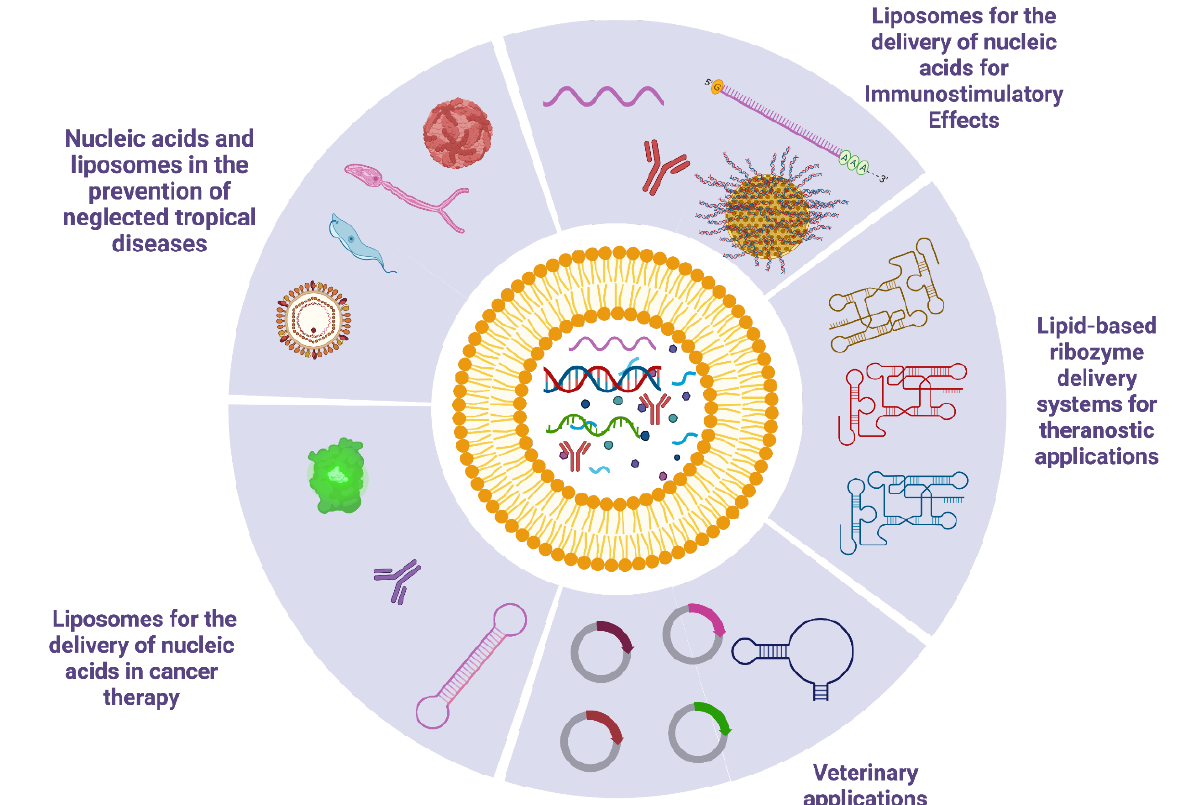
Figure 4. Examples of different nucleotides and their biomedical applications described in this re- view.